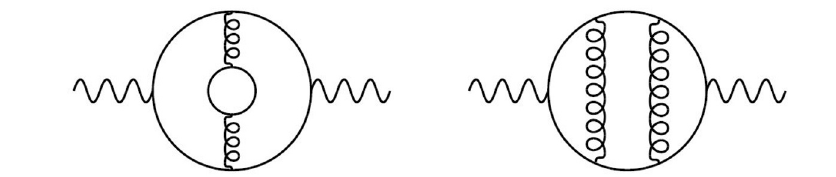
Figure 1 . The specific diagrams, contributing to the β 0 -dependent (within the Naive- Nonabelianization procedure) and conformally invariant terms of d 2 -coefficient